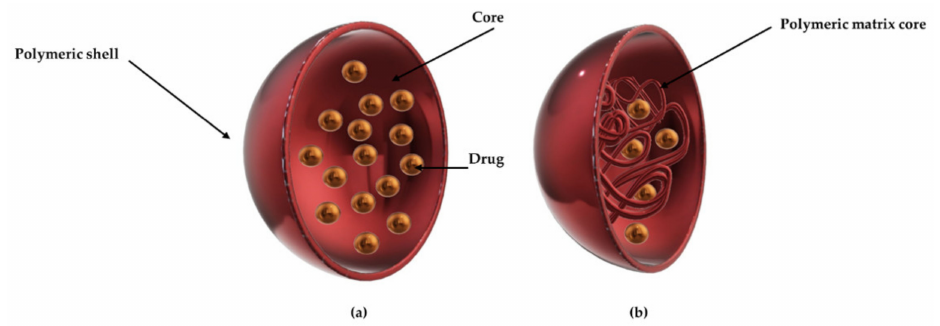
Figure 9. Schematic illustration of ( a ) nanocapsules, ( b )